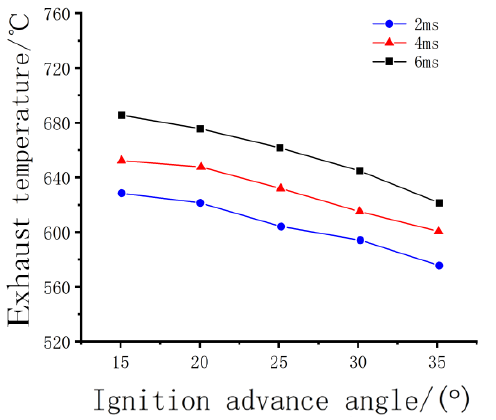
Figure 27. Influence of the ignition parameters on exhaust